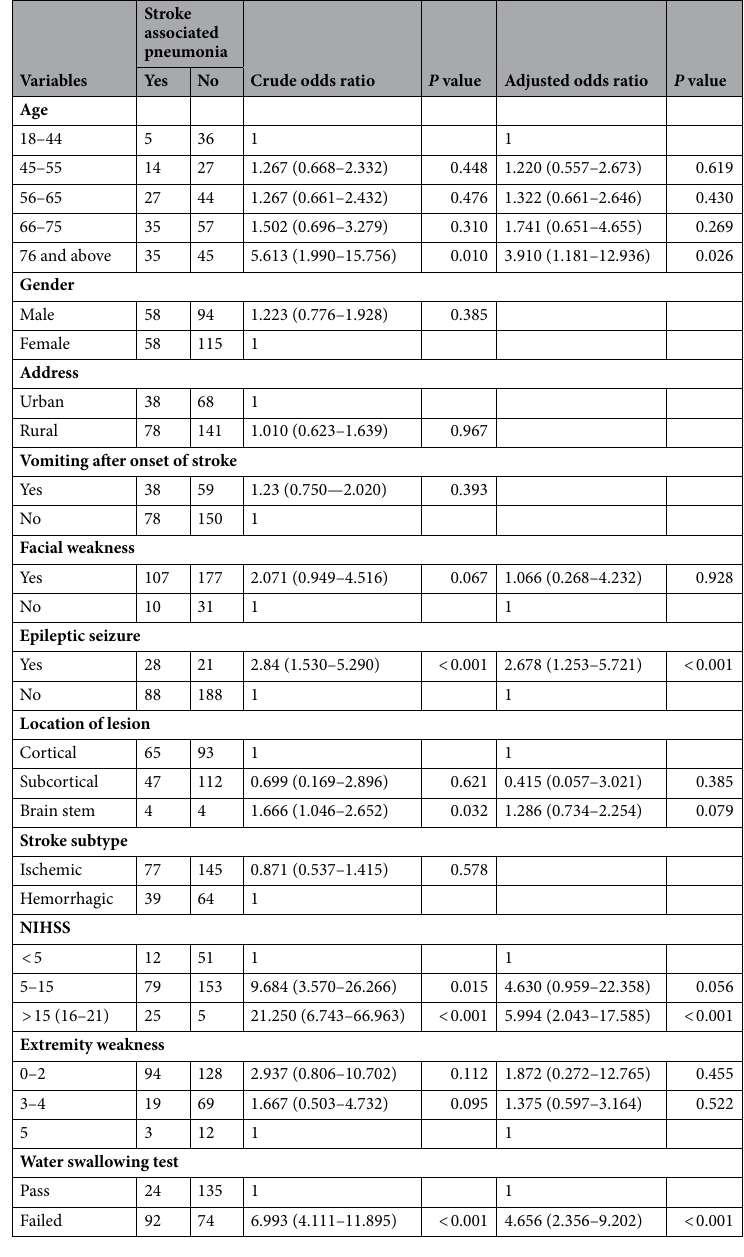
Table 4. Bi-variate and multi-variate analyses of factors associated with stroke associated pneumonia among adult stroke patients admitted to Stroke Care Unit, University of Gondar hospital, January 1 to December 31, 2020. (n =